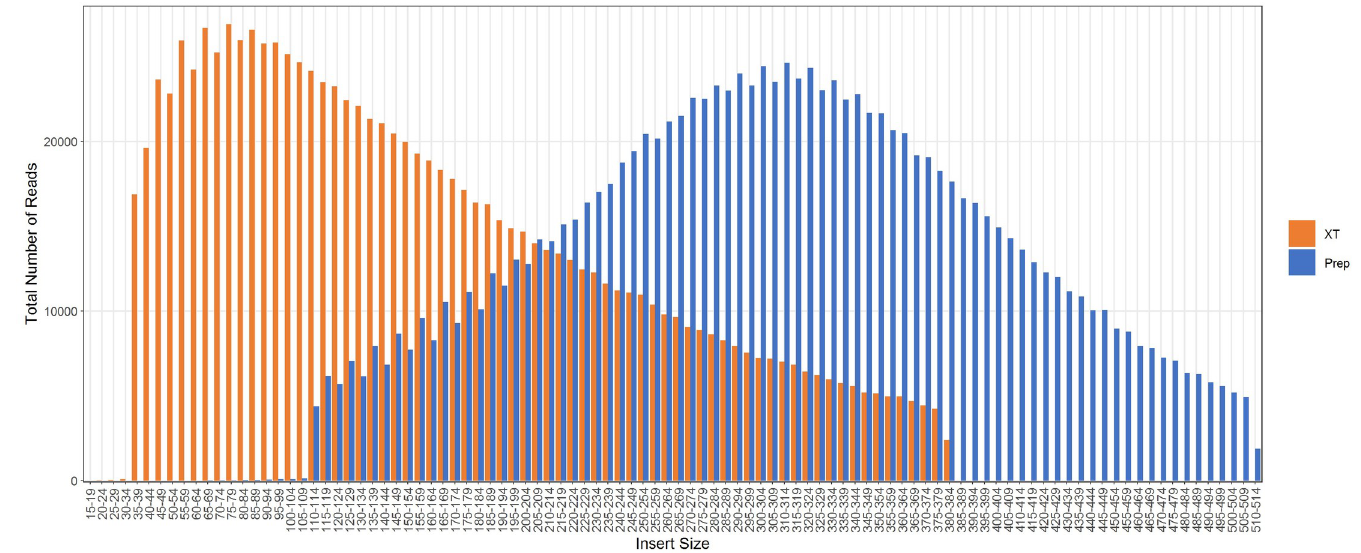
Fig 2. The distribution of the total number of reads based on the size of the paired read length (insert size) for strain CFSAN051560. DNA Prep results are shown in blue and Nextera XT results are shown in orange.